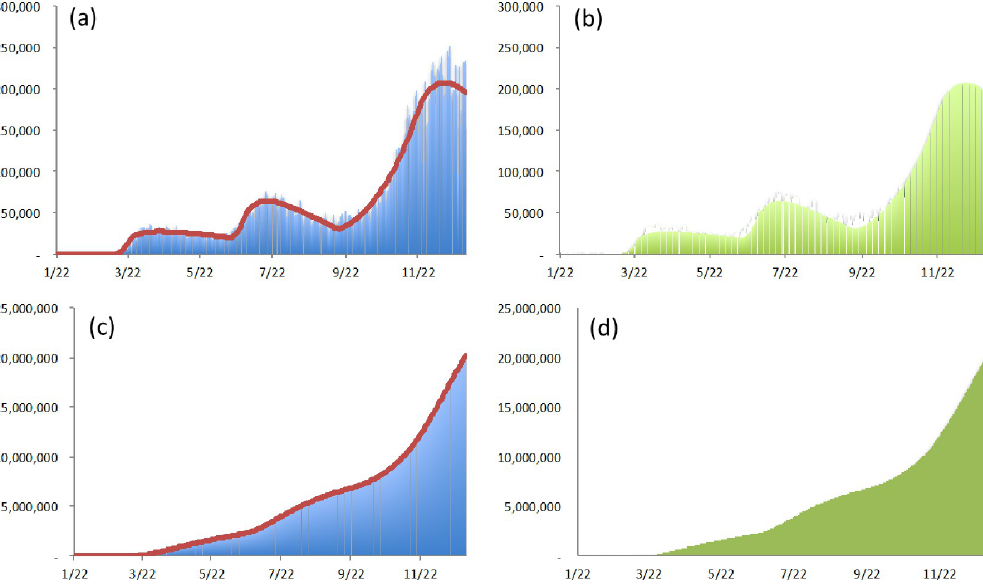
Fig 4. Estimated numbers of confirmed cases in the United States with the partition based on the sources of occurrence. (a) The point-wise number of actual confirmed cases (blue vertical line) and the point-wise number of estimated confirmed cases (red solid line). (b) The point-wise number of estimated confirmed cases from the first wave (orange vertical line), and the point-wise number of estimated confirmed cases from the rapid global diffusion (green vertical line). (c) The cumulative number of actual confirmed cases (blue vertical line) and the cumulative number of estimated confirmed cases (red solid line). (d) The cumulative number of estimated confirmed cases from the first wave (orange vertical line), and the cumulative number of estimated confirmed cases from the rapid global diffusion (green vertical